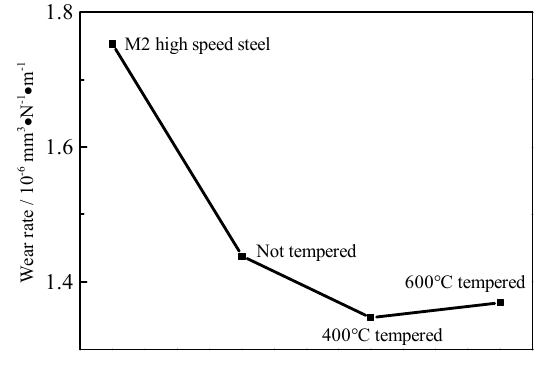
Figure 16. Wear rate of cladding layer.